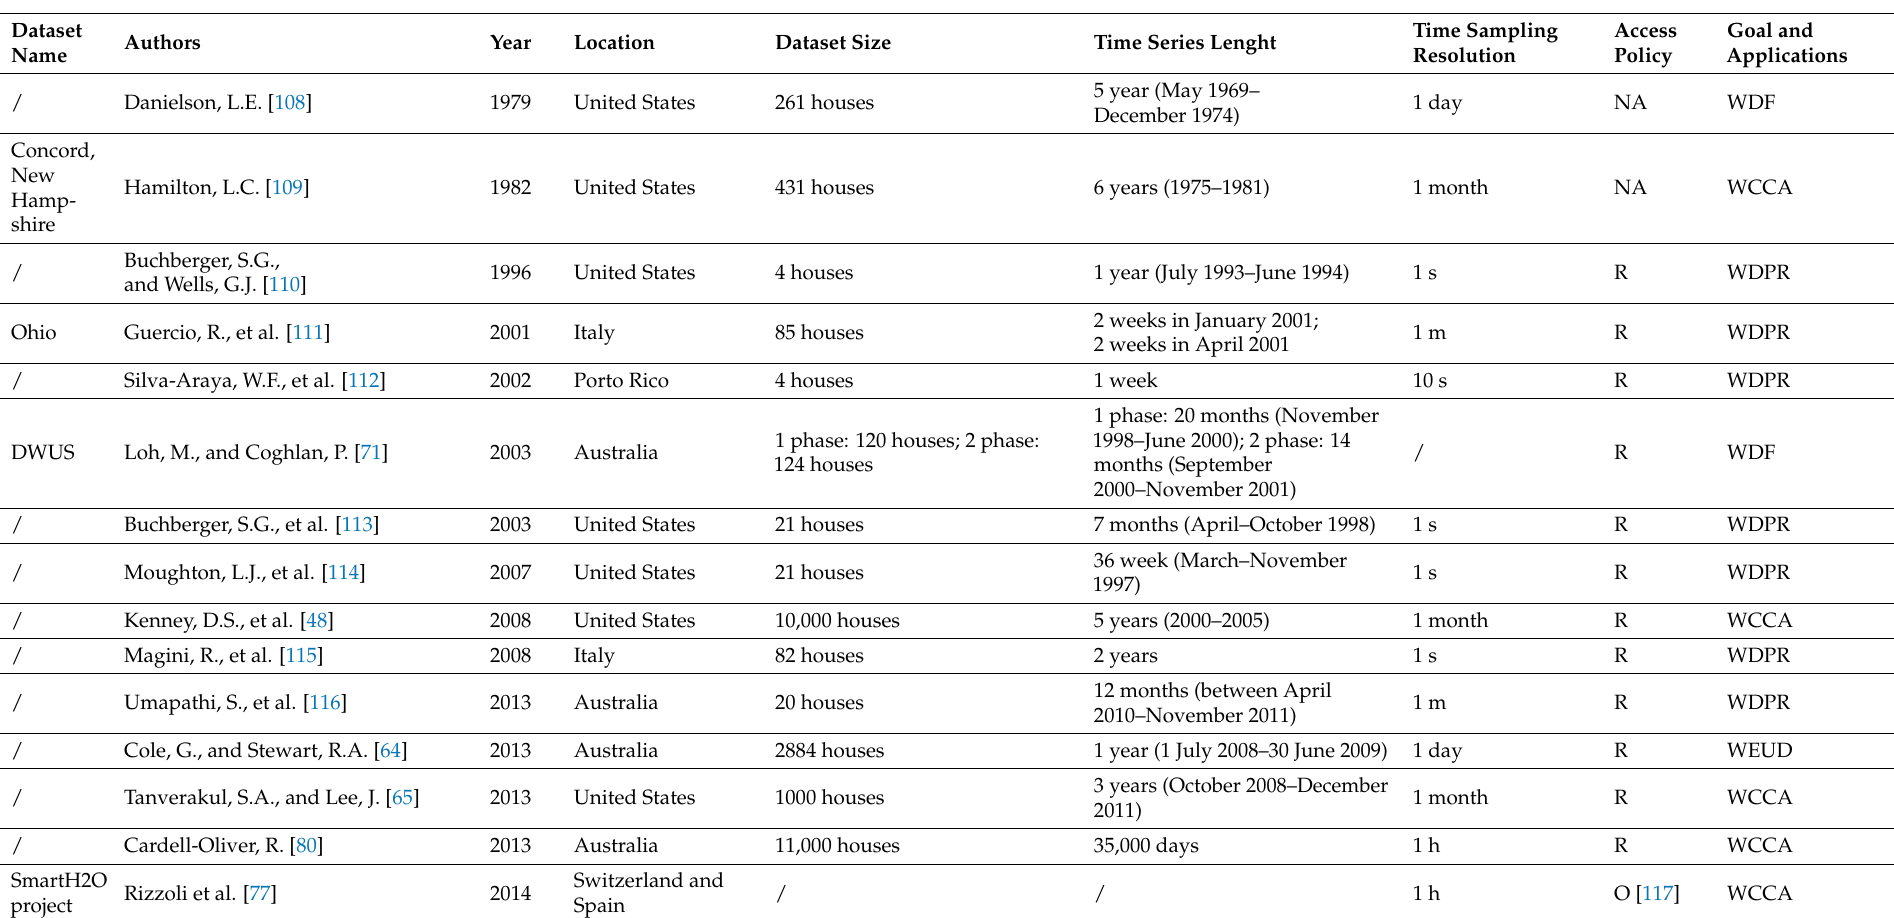
Table 2. Metadata of the 31 reviewed datasets at the household scale. Different goals and applications are considered (see last column): WEUD = Water End Use Disaggregation; WCCA